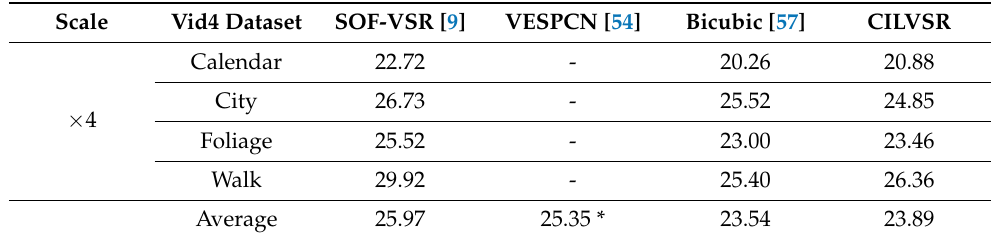
Table 6. Comparative result of PSNR value of proposed method and other technique. The results marked with an asterisk (*) are sourced from the respective papers.